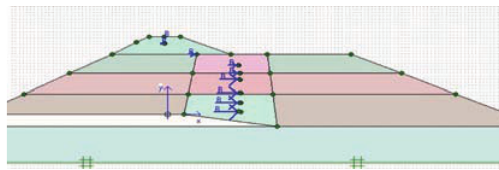
Figure 4: Equivalent static forces acting at layers gravity